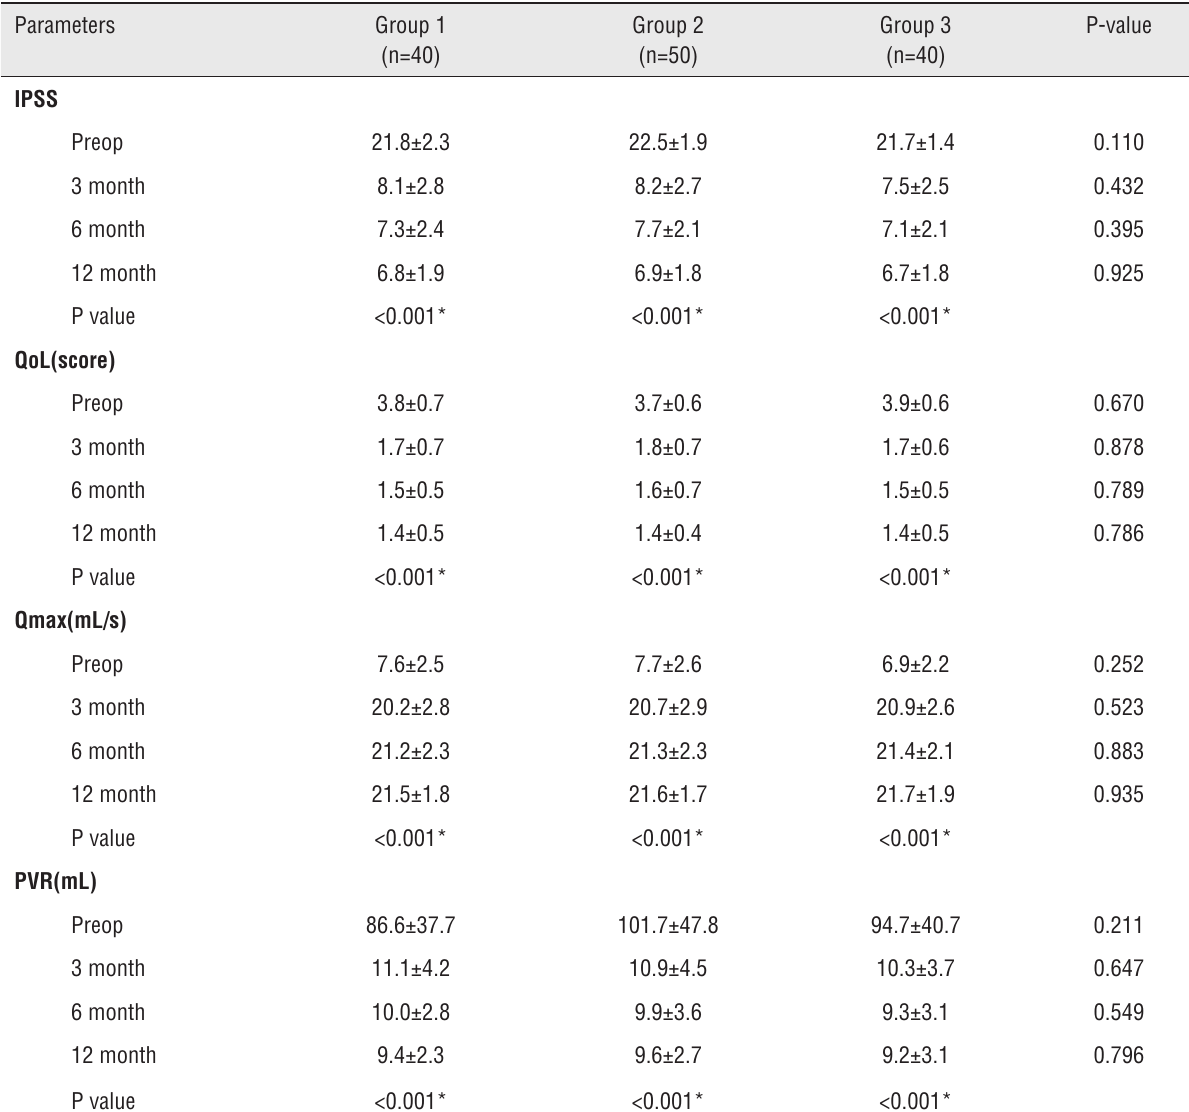
Table 2 - Preoperative characteristics and follow-up